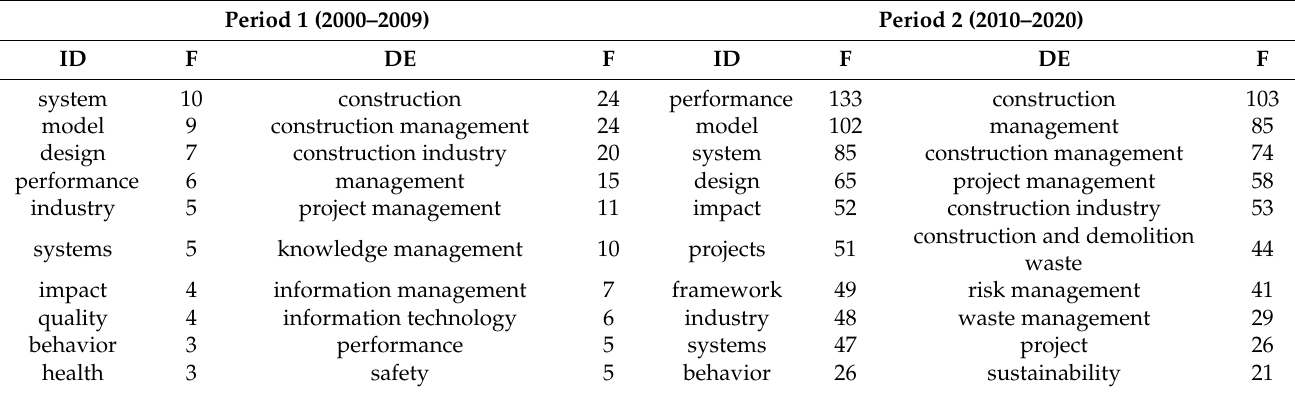
Table 5. Top 10 frequencies of keywords in each period.